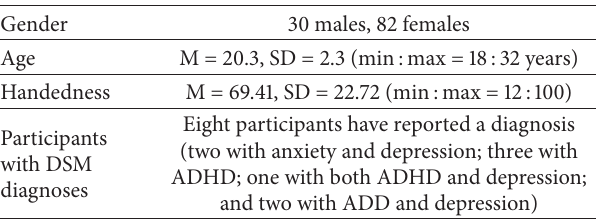
Table 1: Characteristics of study